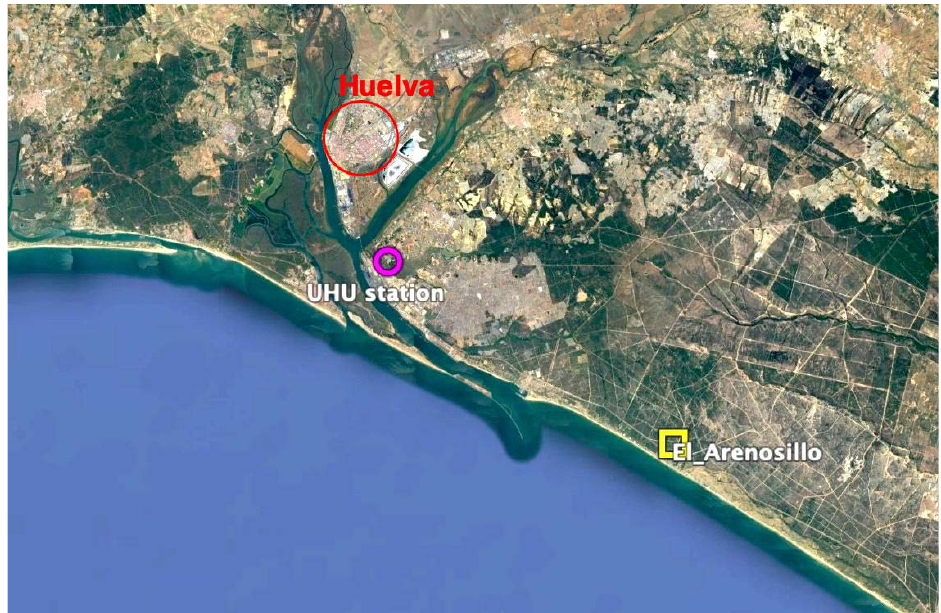
Figure 2. Location of the radiometric and meteorological station of the Universidad de Huelva, Spain (UHU facilities). The city of Huelva and the AERONET station of “El Arenosillo” are also indicated.